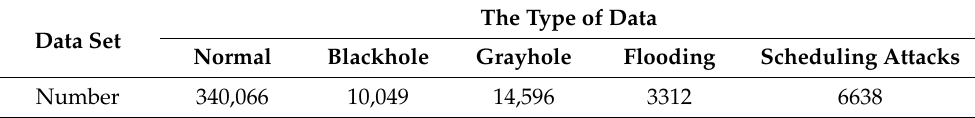
Table 3. The data of WSN-DS.